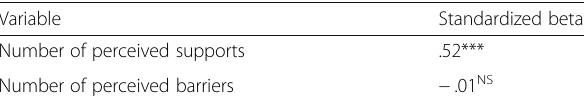
Table 5 Multiple linear regression results with reported implementation as outcome